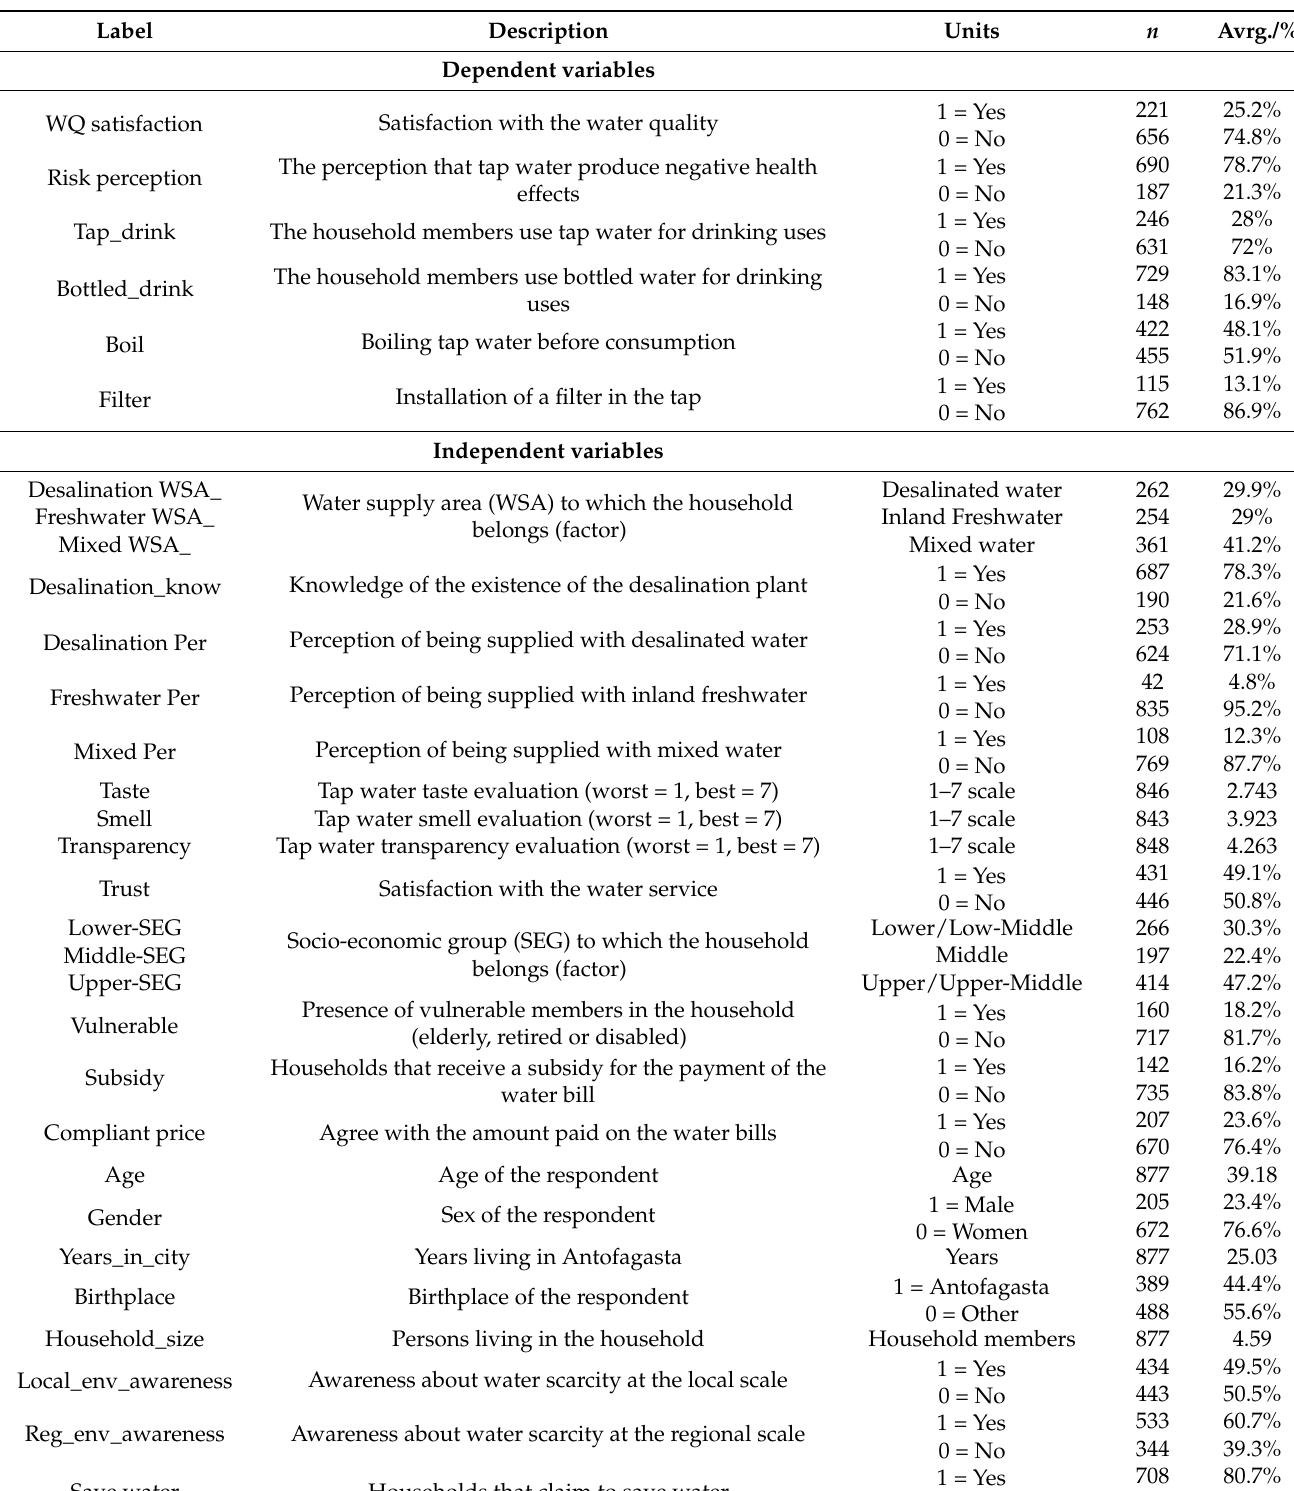
Table 1. List of dependent and independent variables used in the regression models and descriptive statistics.